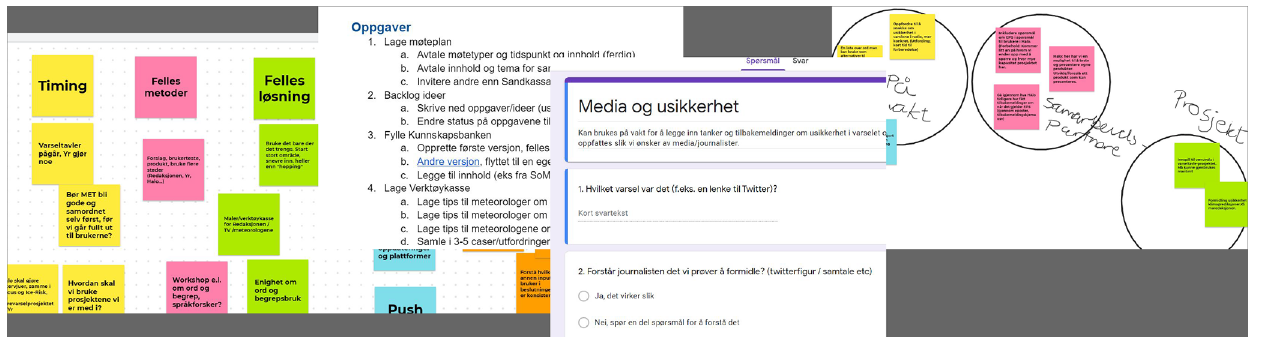
Figure 2. Various Google tools (Meet, Jamboard, Docs, Slides, Sheets, Chat and Gmail) were used when working virtual (in Norwegian). Screenshots by author, from Google Workspace